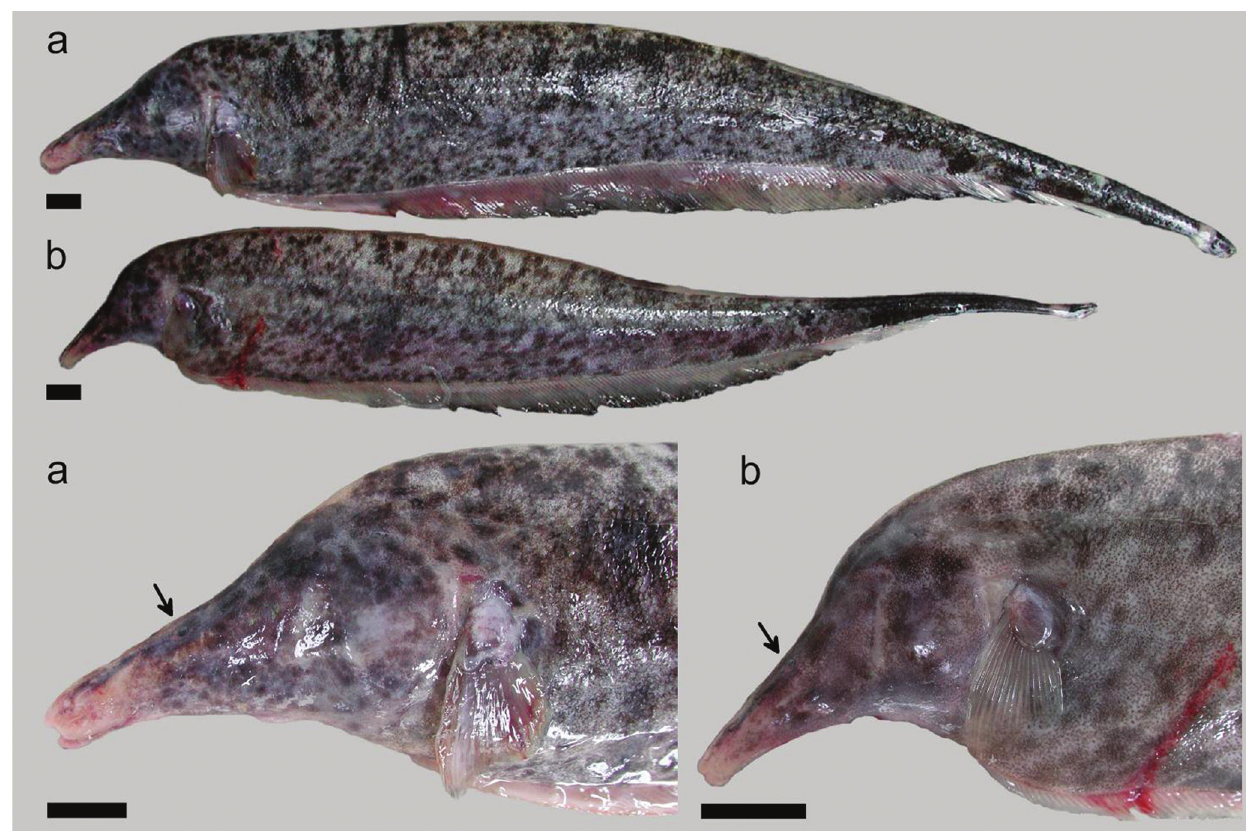
Fig. 2. Live specimens of Apteronotus magdalenensis , showing body and head. a ) IAvH-P 9836 (WC 2005-09-27-01), male; b ) IAvH-P 7026, (WC 2005-09-27-03), female. Scale bars = 10 mm. Arrows show position of